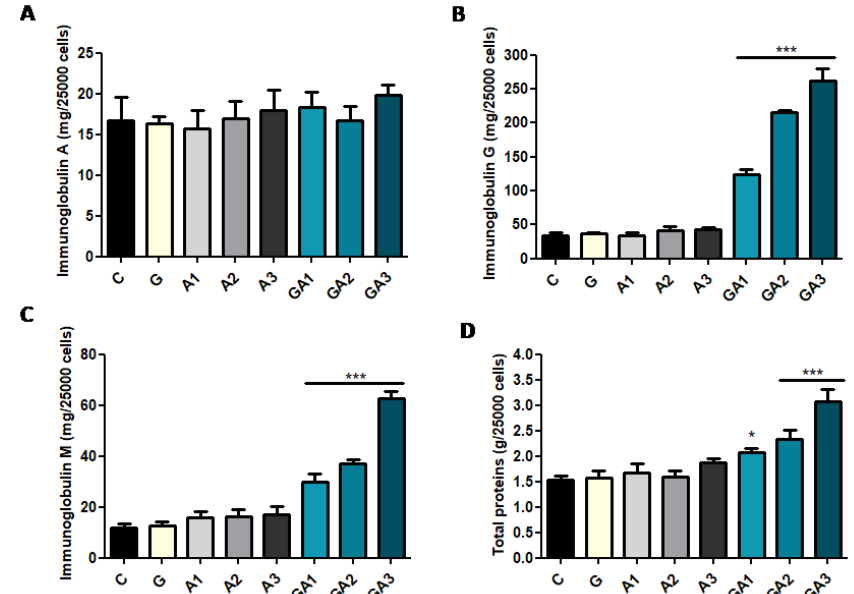
Figure 4. Comparisons of IgA ( A ), IgG ( B ), IgM ( C ) and total proteins ( D ) for the control and allicin-treated groups of CD19+ cells. Allicin and allicin + glutathione treatment did not induce variations in IgA levels. IgG and IgM were increased in allicin + glutathione (GSSA)-treated cells, and the single administration of allicin did not influence IgG and IgM secretion. Values are expressed as mean ± SD (* p < 0.05; ** p < 0.01; *** p < 0.001).